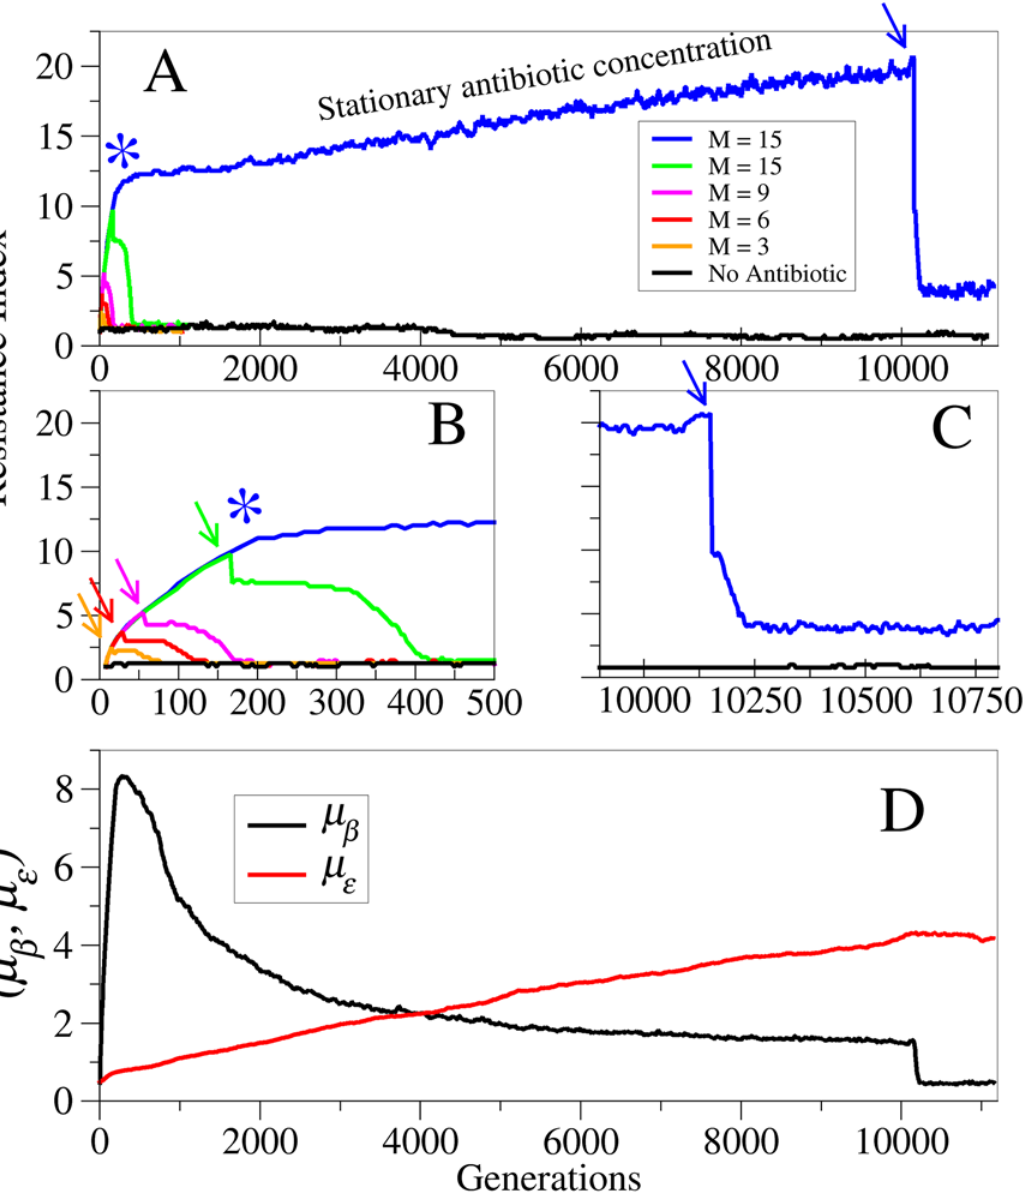
Fig 4. Genetic Assimilation occurs at longer time scales. (A) Resistance Index (RI) as a function of time for populations induced with M antibiotic shocks. The different curves correspond to different values of M , except by the black one which corresponds to a control population growing with no antibiotic. (B) Blow up showing the first 500 generations. For each curve, the corresponding arrow indicates the time at which the antibiotic is removed. In the case of the blue curve, the asterisk indicates the time at which the last antibiotic shock is applied, after which the antibiotic concentration is kept constant. (C) Blow up of the last part of the simulation showing the point at which the antibiotic is removed from the population corresponding to the blue curve. It can be observed that in this case the final stationary value of the RI is about five times higher than that of the control population. (D) Evolution of the average transcription rate μ β and the average pump efficiency μ ε for the population corresponding to the blue curve. Notice that as soon as the antibiotic concentration is kept constant, μ β starts decreasing whereas μ ε keeps rising until the antibiotic is completely removed. This shows that the evolutionary process does not reach a stationary state (or fixed point) in the presence of